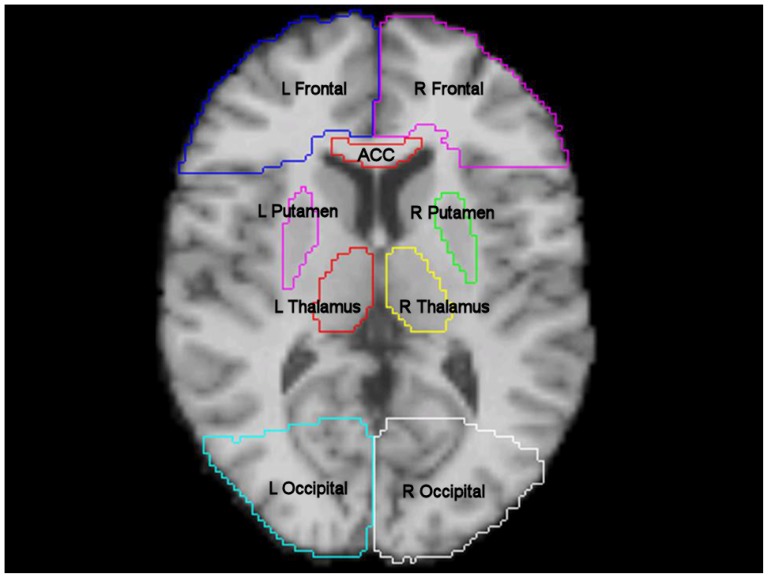
Region of interest template.T1 weighted magnetic resonance image in MNI152 space (2mm resolution) showing frontal lobe left (L Frontal), frontal lobe right (R Frontal), anterior corpus callosum (ACC), thalamus left (L Thalamus), thalamus right (R Thalamus), occipital left (L Occipital), occipital right (R Occipital), putamen left (L Putamen) and putamen right (R Putamen). Additional regions not shown include body corpus callosum, posterior corpus callosum, dorsal mid brain, ventral mid brain and bilateral regions covering the corticospinal tract, anterior thalamic radiation, inferior longitudinal fasciculus, superior longitudinal fasciculus, pallidum, hippocampus, parietal lobe, temporal lobe, cerebral peduncle and pons.